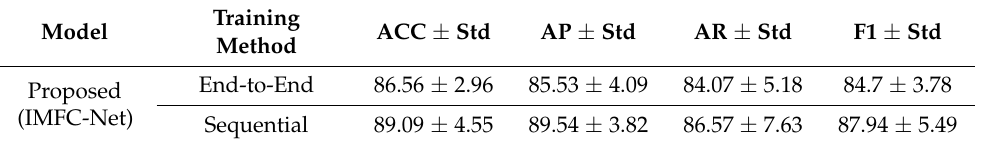
Table 3. Performance analysis between the sequential and end-to-end training of the proposed model using the shoulder implant dataset as an ablation study. (ACC: accuracy, AP: average precision, AR: average recall, F1: F1.score, Std: standard deviation, unit: